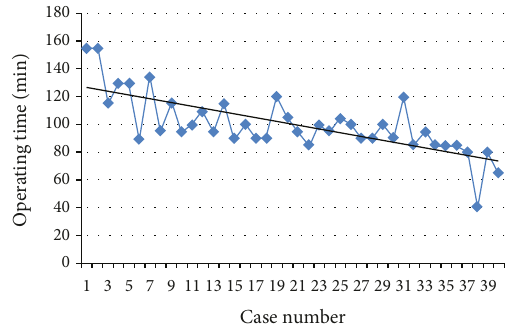
Figure 3: The change of operative time of single-port laparoscopic hepatic left lateral sectionectomy performed in this